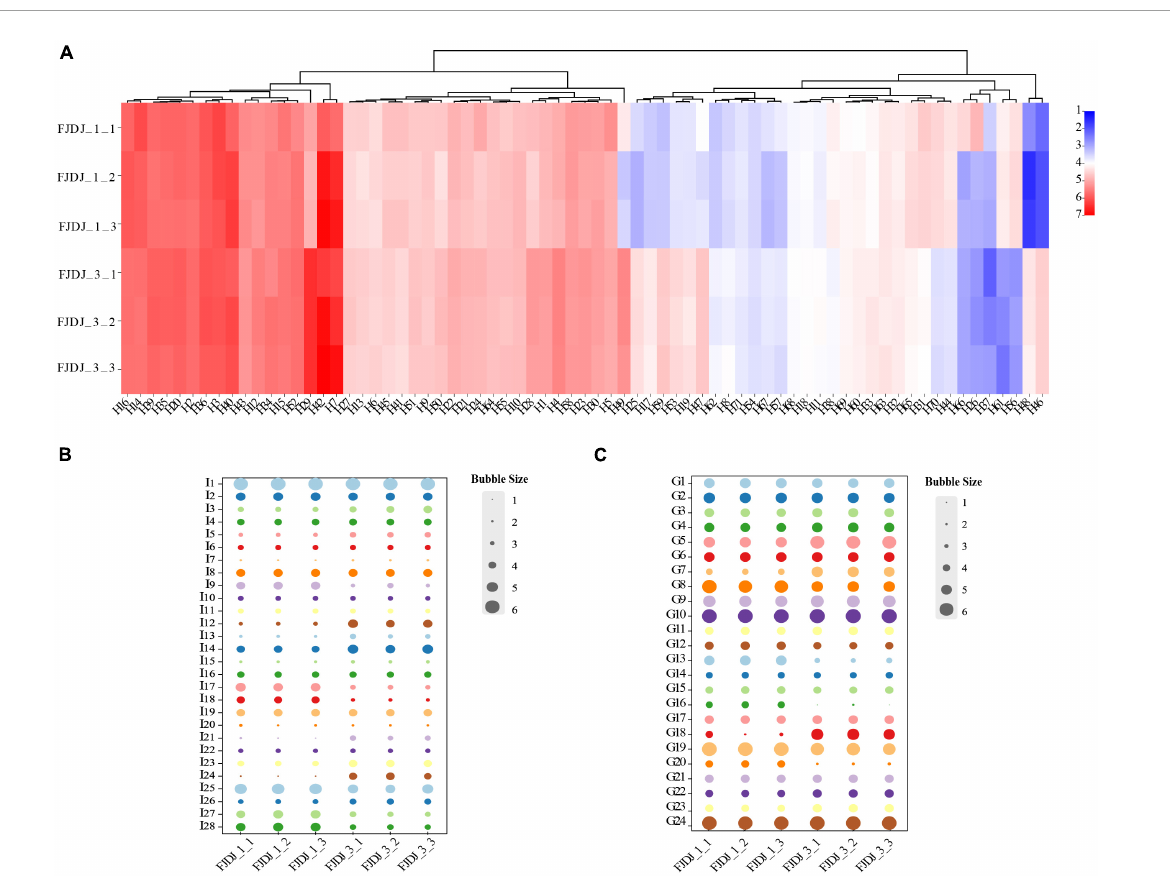
FIGURE5 Key metabolites in RJ and Lactobacillus plantarum fermented juice (LPFJ). Content changes of (A) lipids and lipid-like molecules, (B) amino acids, peptides, and analogs, and (C) carbohydrates and carbohydrate conjugates. FJDJ1-1, FJDJ1-2, FJDJ1-2 belong to RJ; FJDJ3-1, FJDJ3-2, and FJDJ3-2 belong to